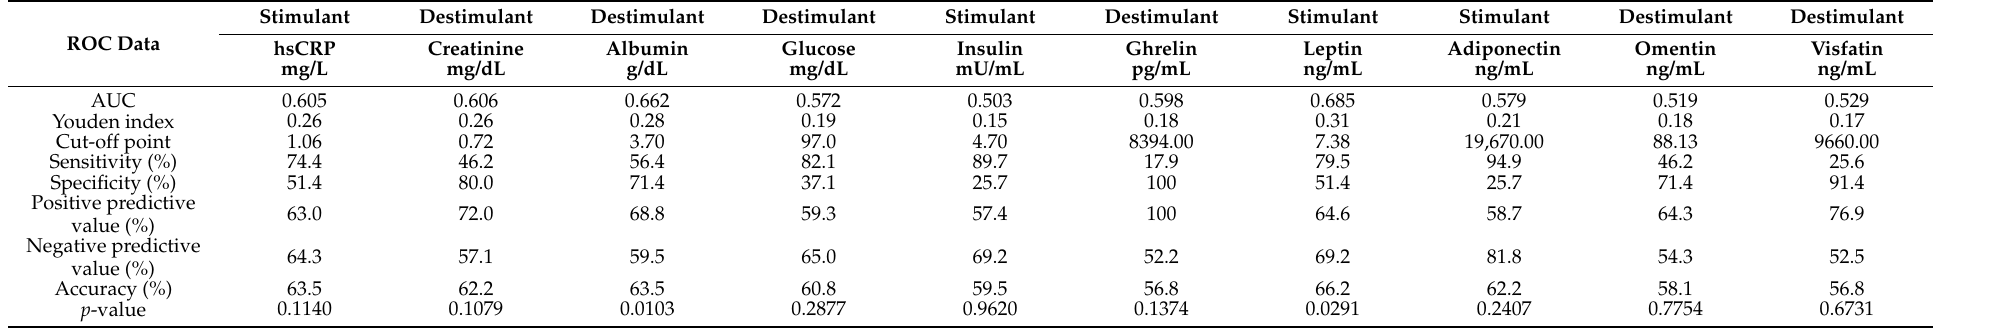
Table 6. Results of diagnostic accuracy for the prediction of vitamin D fluctuation.